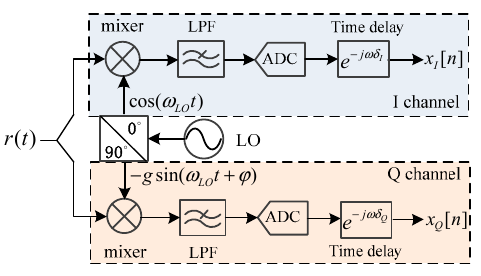
Figure 1. LPI model of the zero-IF Receiver.